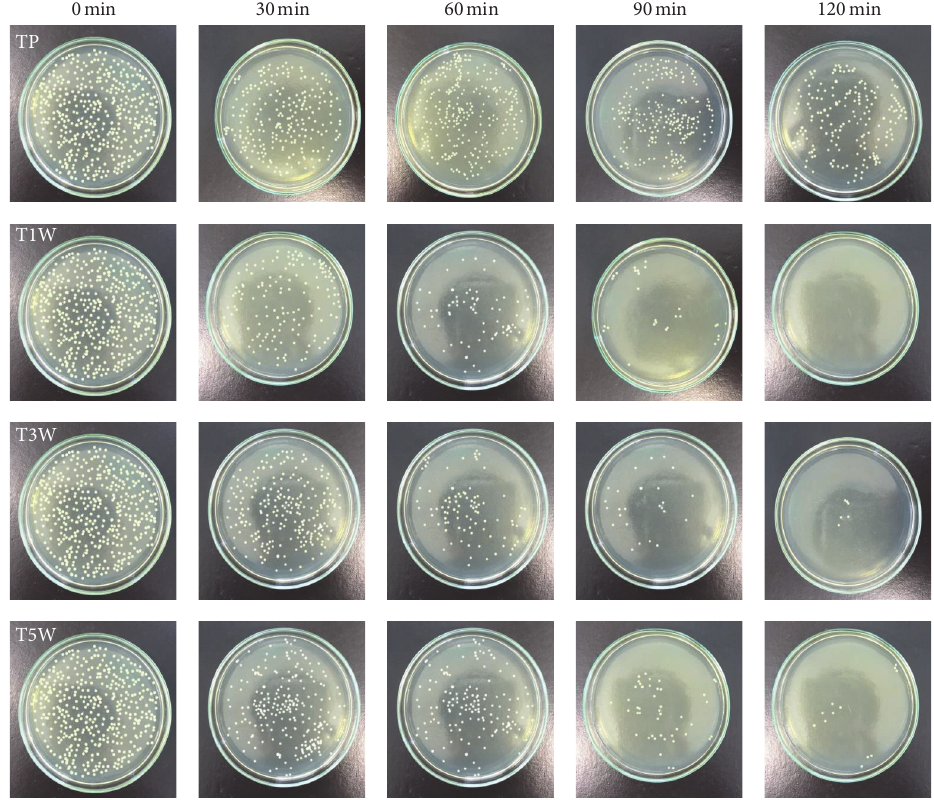
Figure 8: Photo of viable E. coli colonies on synthesized WO 3 -doped TiO 2 coated